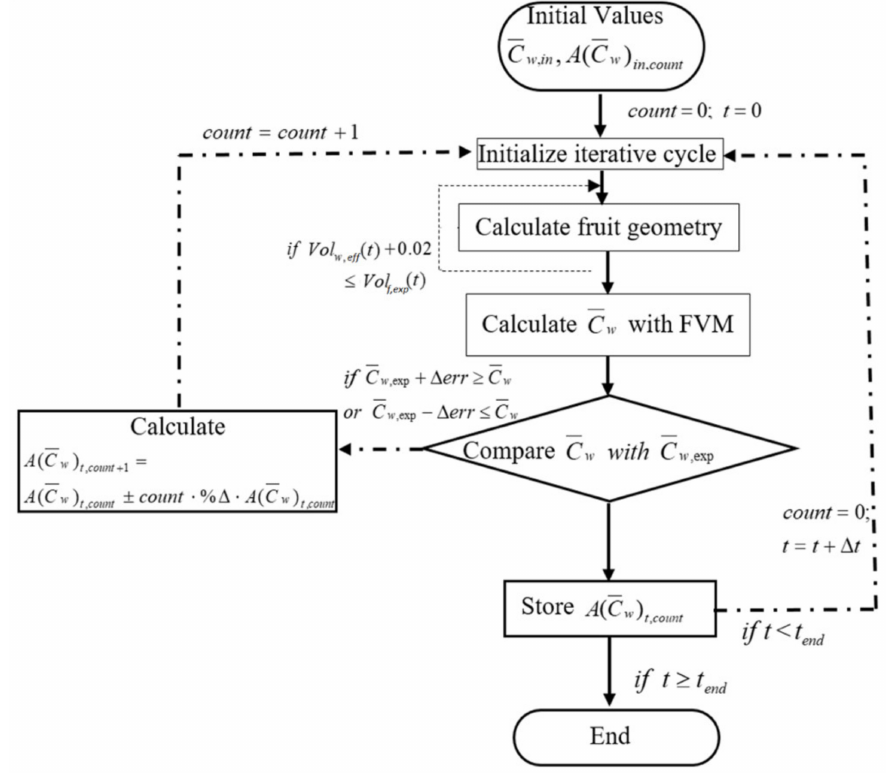
(cid:0) (cid:1) C w and the change